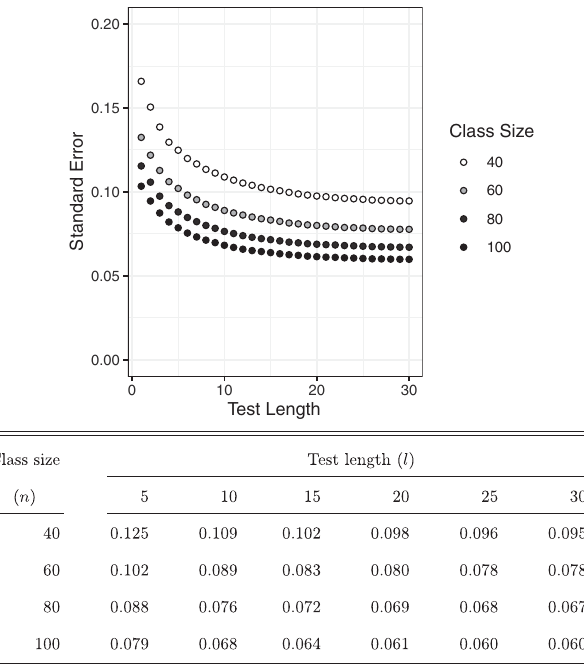
FIG. 6. The standard error of Cohen ’ s d as a function of test length of the FCI-CAT, as calculated by Monte Carlo simulation [class size ¼ ð 40 ; 60 ; 80 ; 100 Þ , sample size ¼ 10 000 classes]. The true value of Cohen ’ s d is 0.38. The values in the table are characteristic points plotted in the